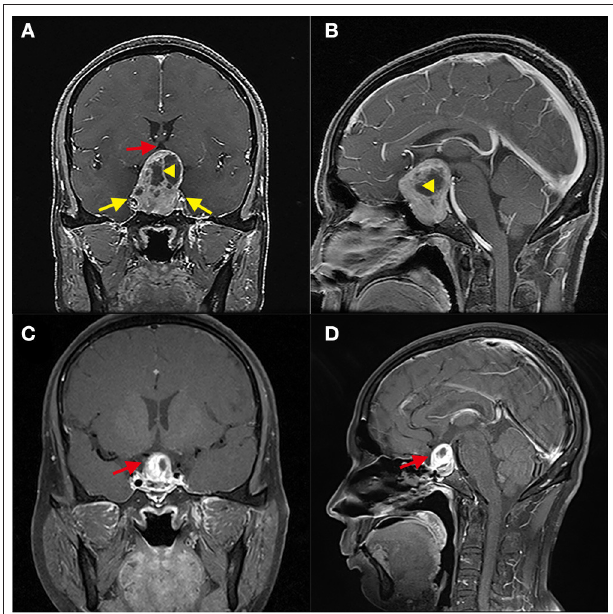
FIGURE 3 | Greater proportion of tumor suprasellar volume limits the gross-total resection of GPA. (A,B) Patient 5, The tumor squeezed bilateral cavernous sinuses (yellow arrow); the proportion of the suprasellar part volume of the tumor is about 60%. The suprasellar tumor contained a cyst (Yellow triangle) and compressed the third ventricle (red arrow). (C,D) Three months after the operation, the residual tumor was located above the sellar area and partially sunk into the sellar area (red